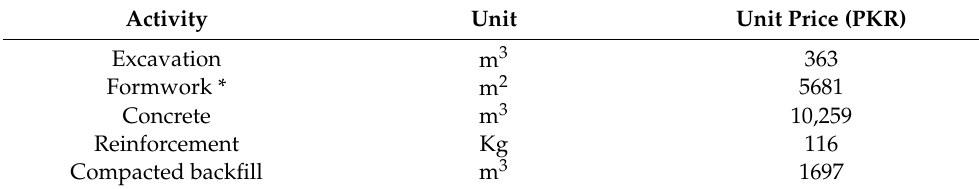
Table 1. Summary of unit prices for a shallow foundation. Activity Unit Unit Price (PKR) Excavation m 3 363 Formwork * m 2 5681 Concrete m 3 10,259 Reinforcement Kg 116 Compacted backfill m 3